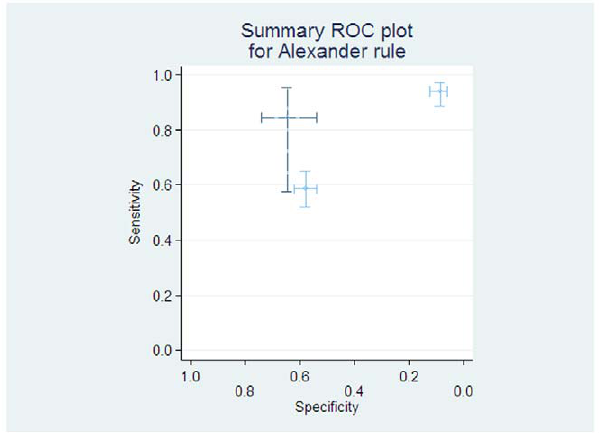
Figure 4. Individual diagnostic test accuracy of ‘Alexander’ rule. The light lines and circles represent individual studies, with the darker dashed lines showing the study from which the rule was derived.